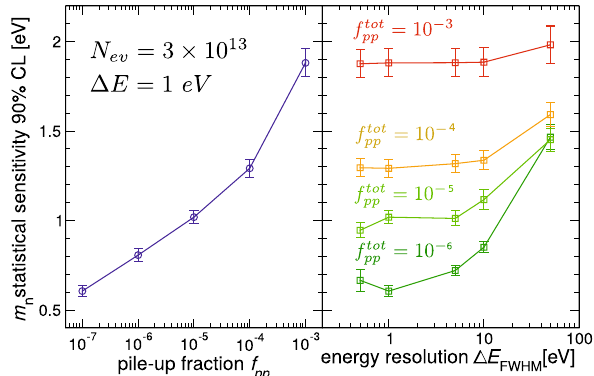
Fig. 3 ExpectedneutrinomasssentivityfortheHOLMESexperiment. The right panel shows the sensitivity compared to the detectors energy resolution at different pile-up fraction. We called the pile-up fraction on the whole energy spectrum f tot